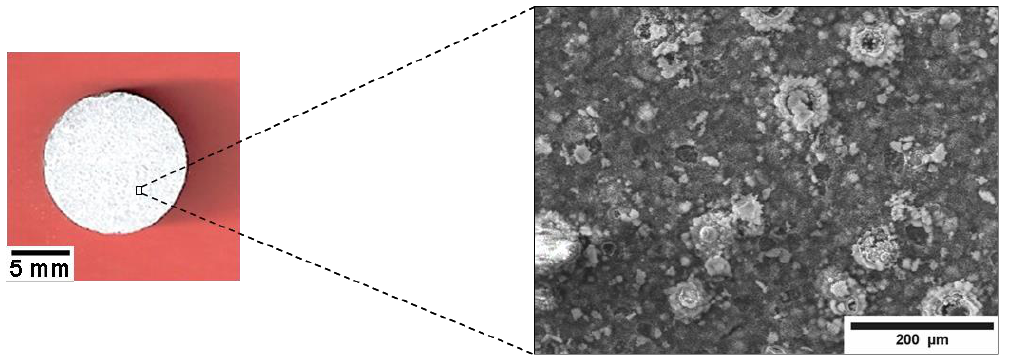
Figure 9. Photograph and SEM image of a calcium phosphate coating electrodeposited with direct current at 15 mA cm −2 . Reprinted with permission from Ref. [72].Copyright 2010 Wiley.